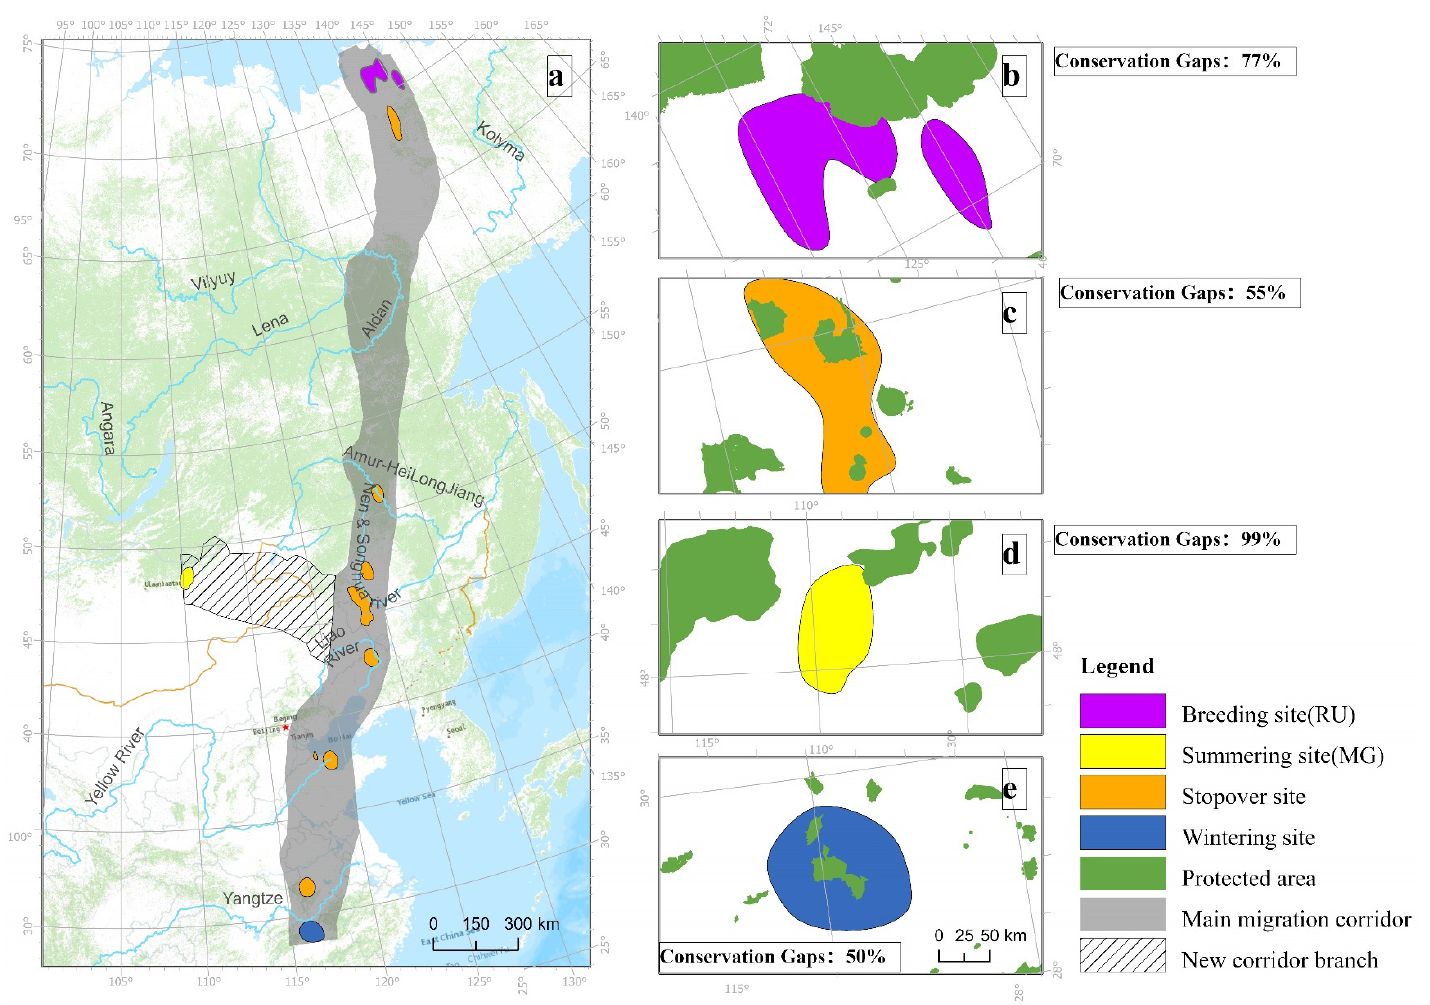
Figure 4. Mapping of the Siberian crane ( Leucogeranus leucogeranus ) flyway structure. ( a ) Maps of the main migration corridors and new corridor branch. ( b – e ) Maps of critical habitat extents used in the breeding, staging/stopover, summering, and wintering periods, as confirmed by the GPS fixes using kernel density estimation (KDE).